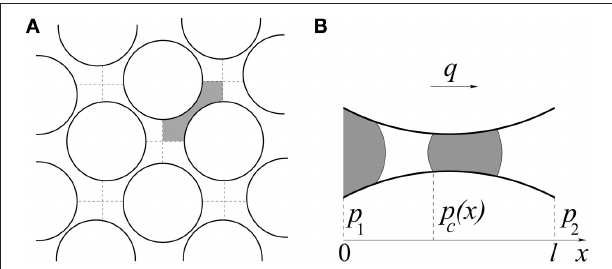
FIGURE 1 | (A) Illustration of the pore network model, constructed by links (tubes) with random radii connected to each other via nodes at the intersection of the dashed lines. One single link in the network is highlighted by gray which is again shown in (B) filled with two fluids. The wetting and non-wetting fluids are colored by white and gray, respectively. p 1 and p 2 are the pressures at the two ends of the link and q is the local flow-rate. There are three menisci inside and capillary pressure difference at a menisci is indicated as p c ( x )